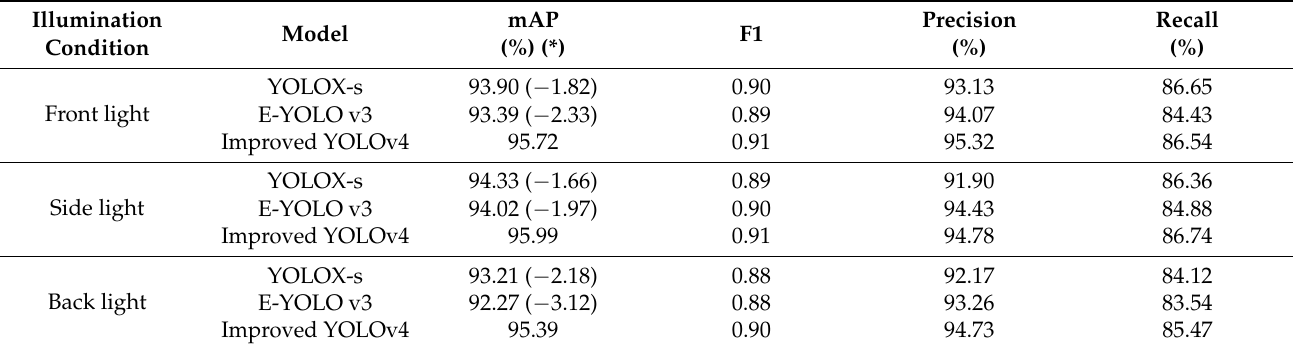
Table 5. Comparison of the three models in different illumination data